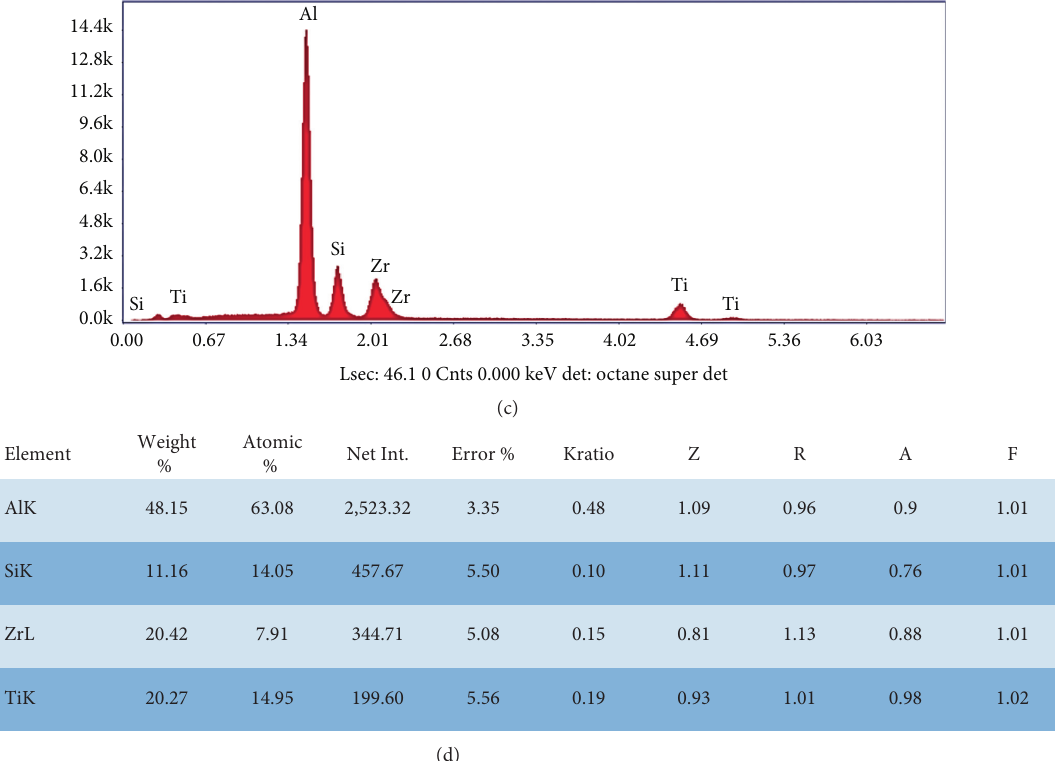
Figure 7: (a) Bright field electron micrograph of the precipitation of Al-Zr-Ti dispersoids in alloy D in the as-cast condition, (b) map of Zr distribution in (a), (c) EDS spectrum corresponding to white circle in (a), and (d) approximate composition of particles in (a). The average size of Zr-rich precipitates in (a) is about